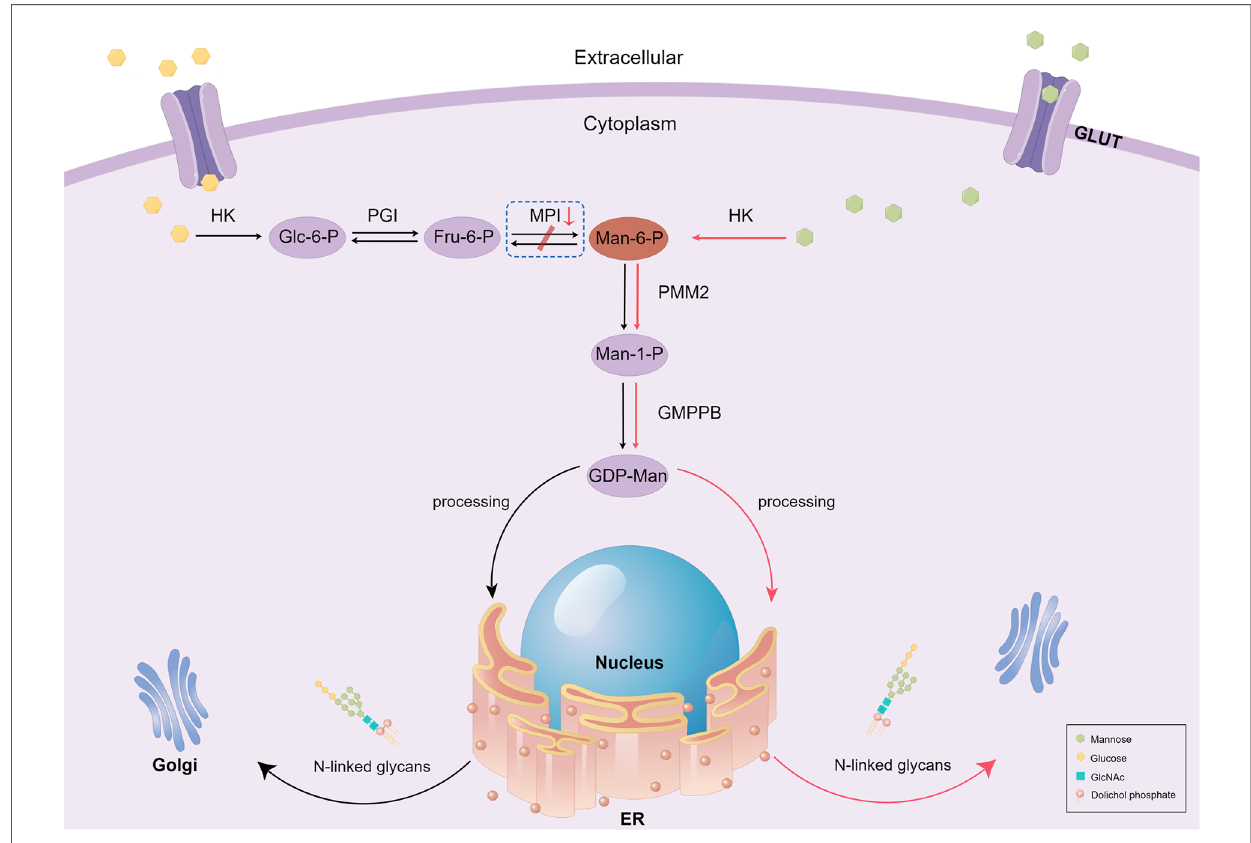
FIGURE 2 Schematic diagram of mannose metabolism and therapy in MPI-CDG patients. In this fi gure, we only present the part related to the MPI defects. Black arrows represent normal mannose metabolism, and the box with dashed lines represents when the process goes wrong. Red arrows represent the mechanism underlying exogenous mannose ’ s therapeutic action in MPI-CDG. GULT, glucose transport; HK, hexokinase; Glc-6-P, glucose-6- phosphate; PGI, phosphoglucose isomerase; Fru-6-P, fructose-6-phosphate; MPI, mannose phosphate isomerase; Man-6-P, mannose-6-phosphate; PMM2, phosphomannomutase 2; Man-1-P, mannose-1-phosphate; GMPPB, GDP-mannose pyrophosphorylase B; ER, endoplasmic reticulum; Golgi, Golgi apparatus; GlcNAc, N-acetyl